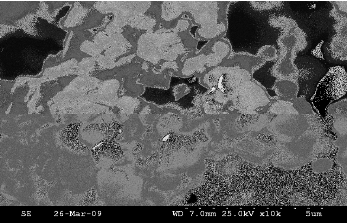
Figure 4a. SEM micrograph of LiNiO 2